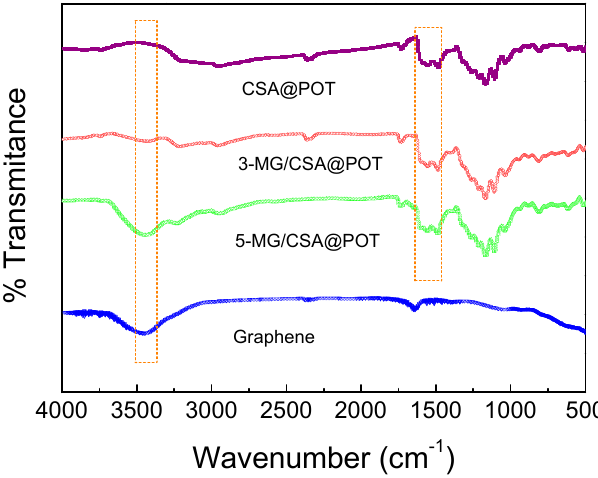
Figure 2. FTIR spectra of graphene, CSA@POT, 3-MG/CSA@POT, and 5-MG/CSA@POT.